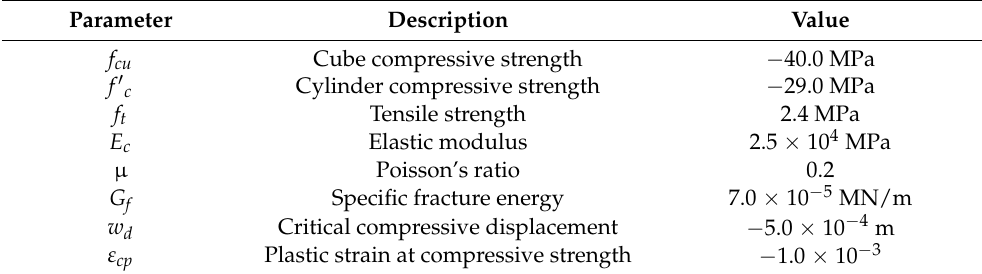
Figure 13. Constitutive laws of “CC3DNonLinCementitious2”: ( a ) compressive hardening; ( b ) compressive softening; ( c ) tensile softening. Table 5. Input data for concrete properties.